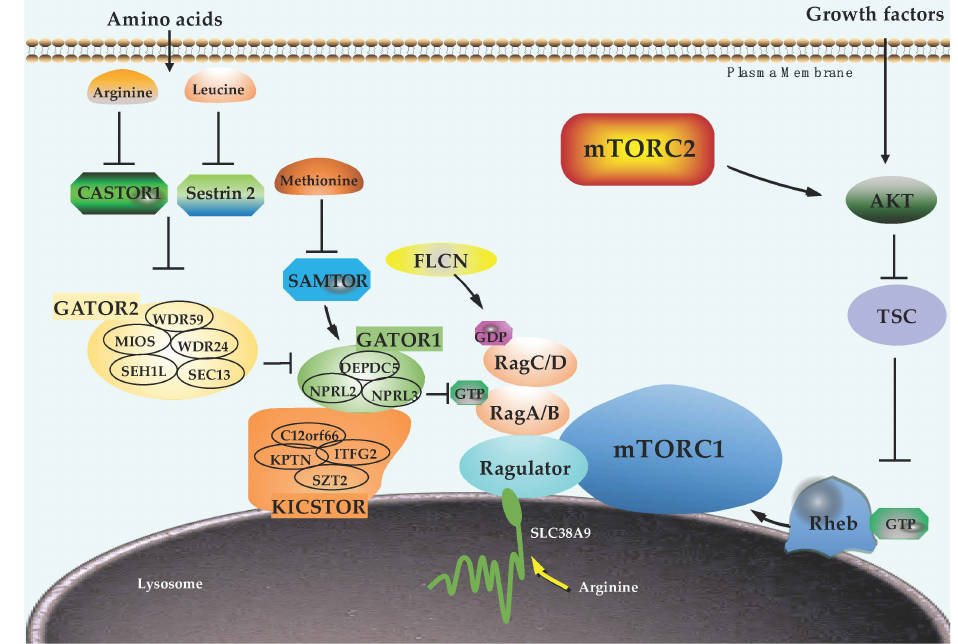
Figure 2. Amino acids and growth factors-mediated activation of the mTORC1 signaling. Amino acids bind to their specific sensors and transduce the signal through GATOR2, GATOR1, KICSTOR, and Ragulator complexes, leading to activation of Rag small GTPases and lysosomal recruitment of mTORC1. Growth factors activate other lysosomal localized small GTPases Rheb through Akt/TSC signaling axis. The small GTPases Rags and Rheb form two arms to fully activate mTORC1 pathway in response to amino acids and growth factors.